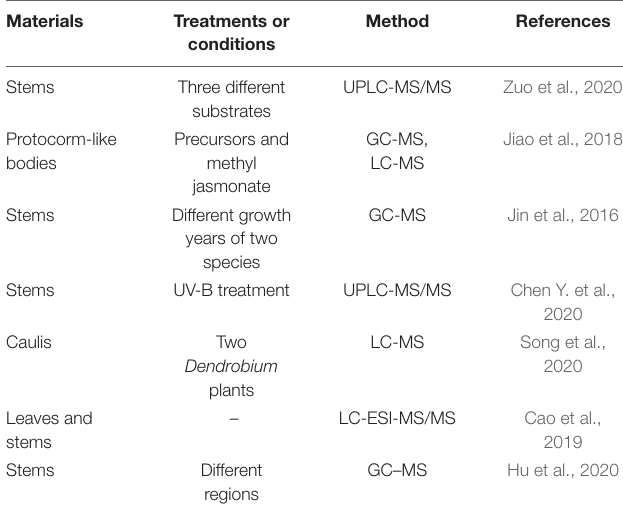
TABLE 3 | A summary of metabolomic studies in D.